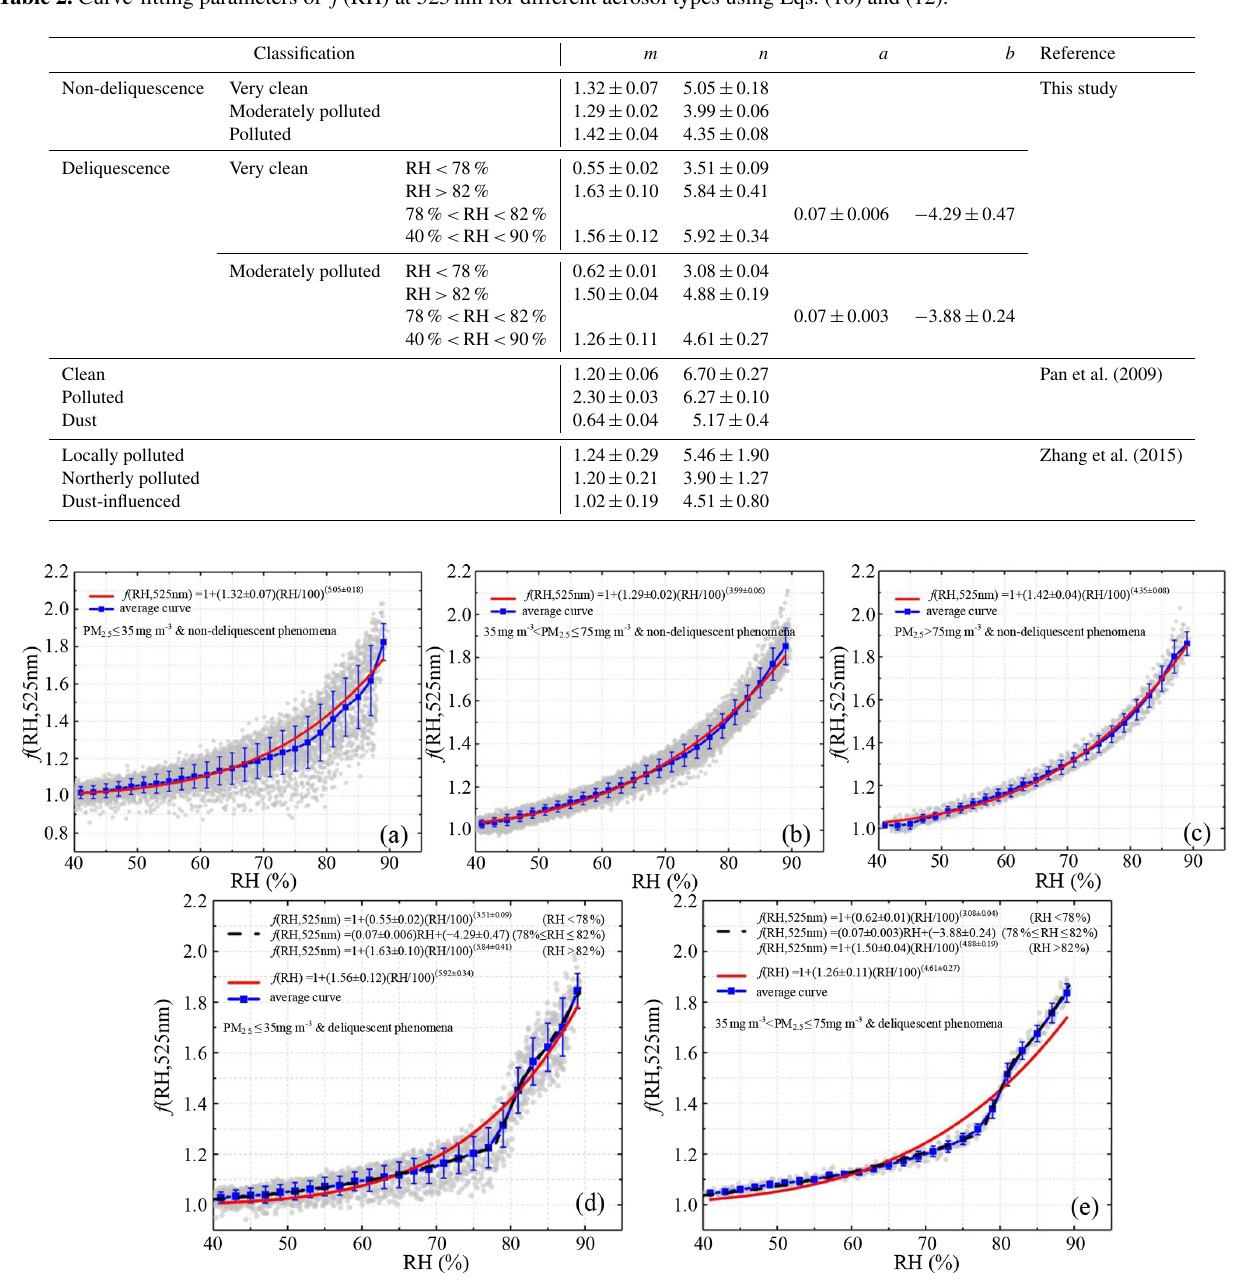
Figure 9. Fitted f (RH) of non-deliquescent curves (a–c) and deliquescent curves (d–e) for different pollution levels. Solid red lines represent fitted curves parameterized by Eq. (10). Dotted black lines represent the curves fit by segment function Eq. (12), and the solid blue lines represent the average